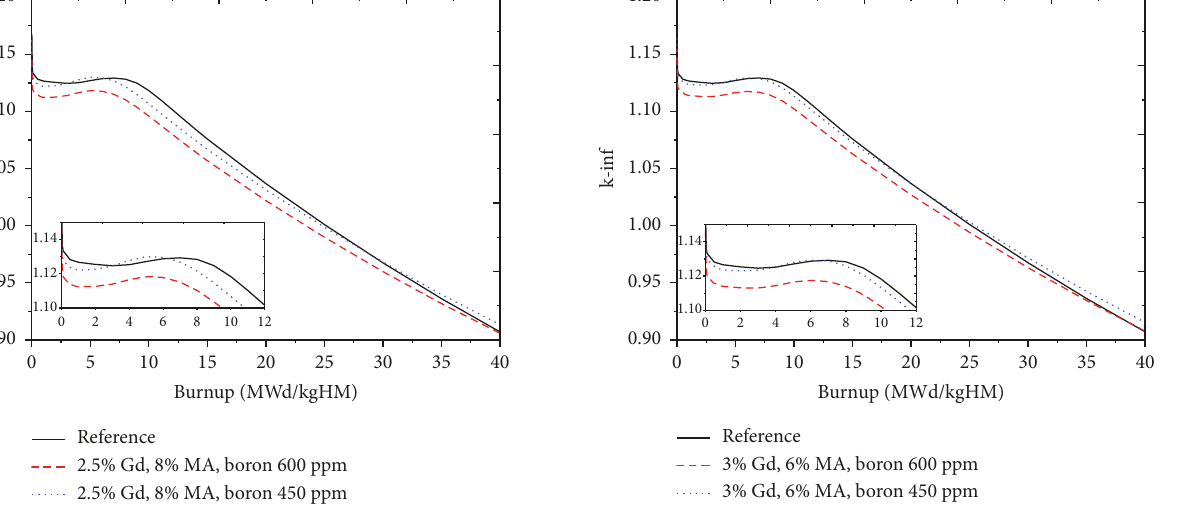
Figure 8: The k-inf versus burnup when loading 8wt.% of MAs and reducing GD to 2.5 wt.%.